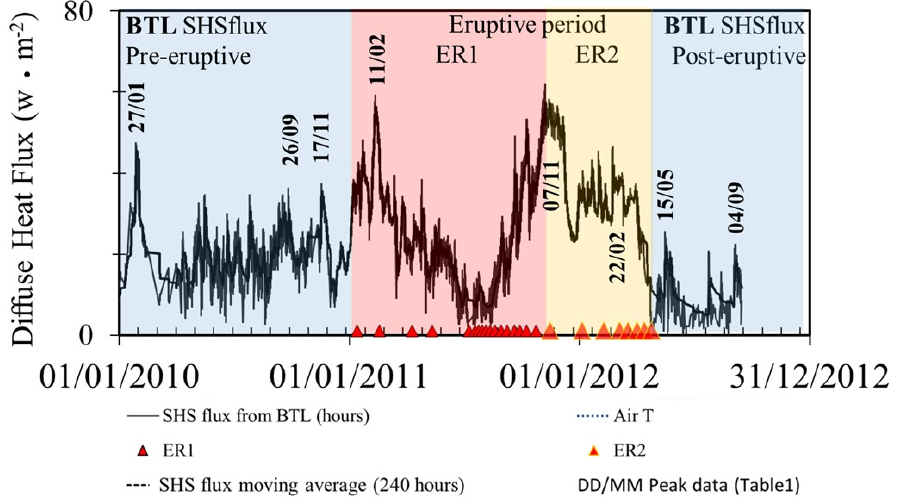
Figure 4. Time variation of the Z1 depths showing the pulses of the convective front below the BTL station. The different colors in the background indicate the different volcanic phases.